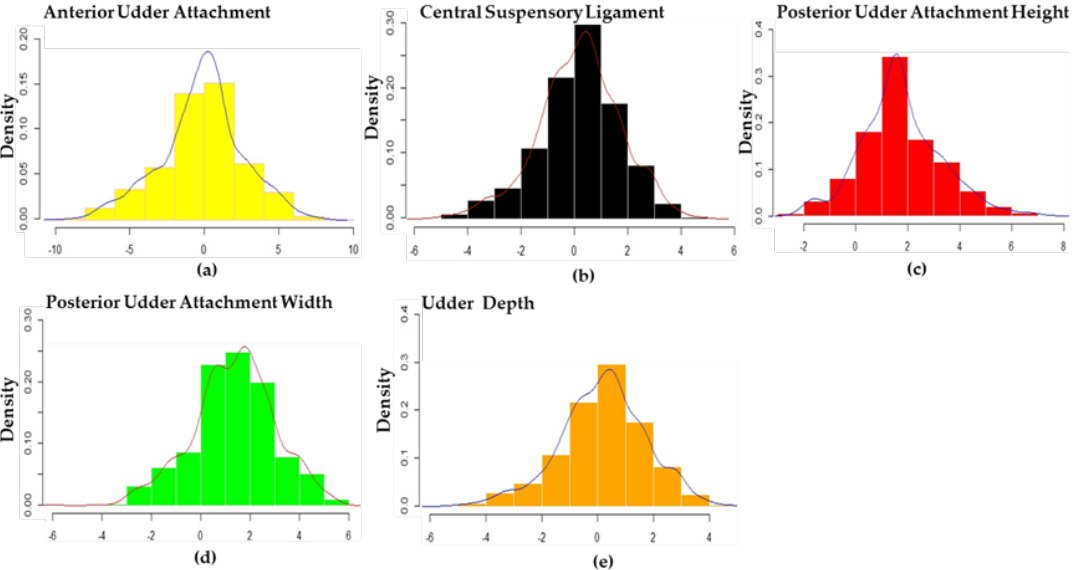
Figure 1. Distribution of the adjusted phenotype of AUA ( a ), CSL ( b ), PUAH ( c ), PUAW ( d ), and UD ( e ) in the population of Holstein cows. The adjusted phenotypes of the five traits shown about normal distribution.